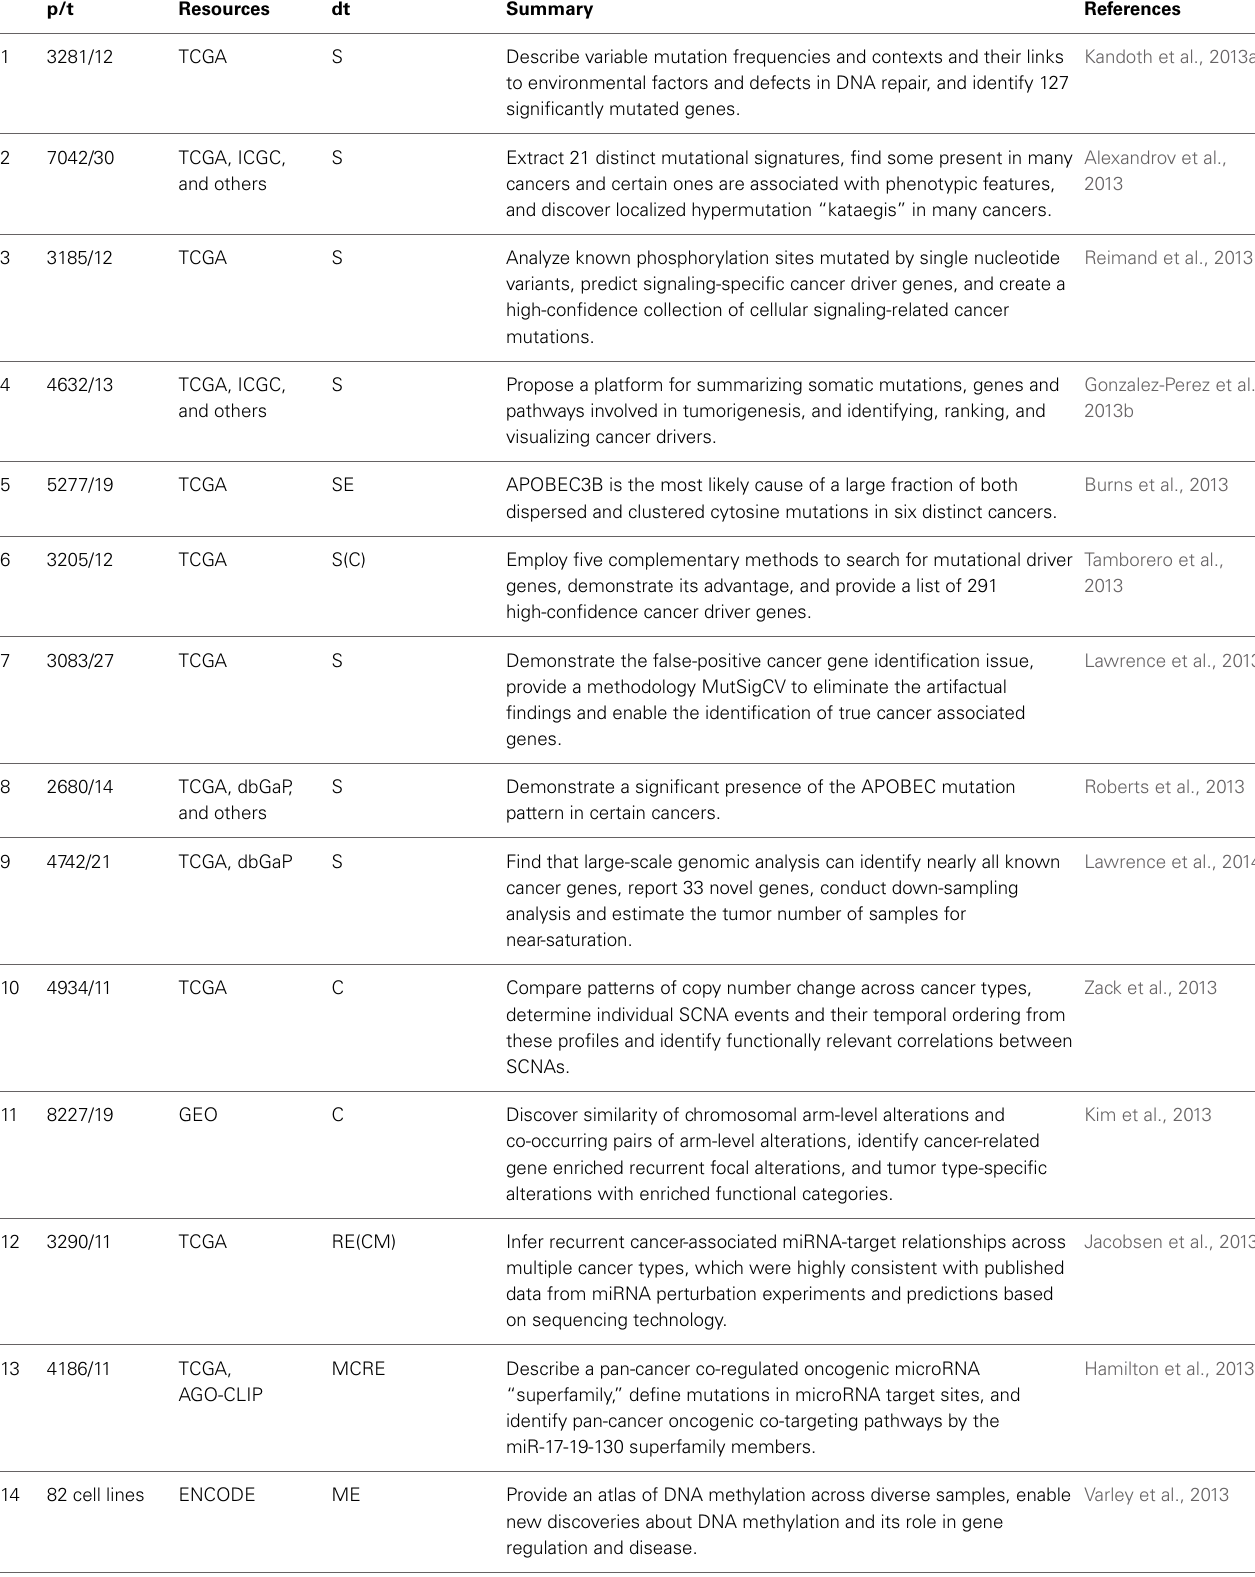
Table 1 | Brief summary of recent pan-cancer